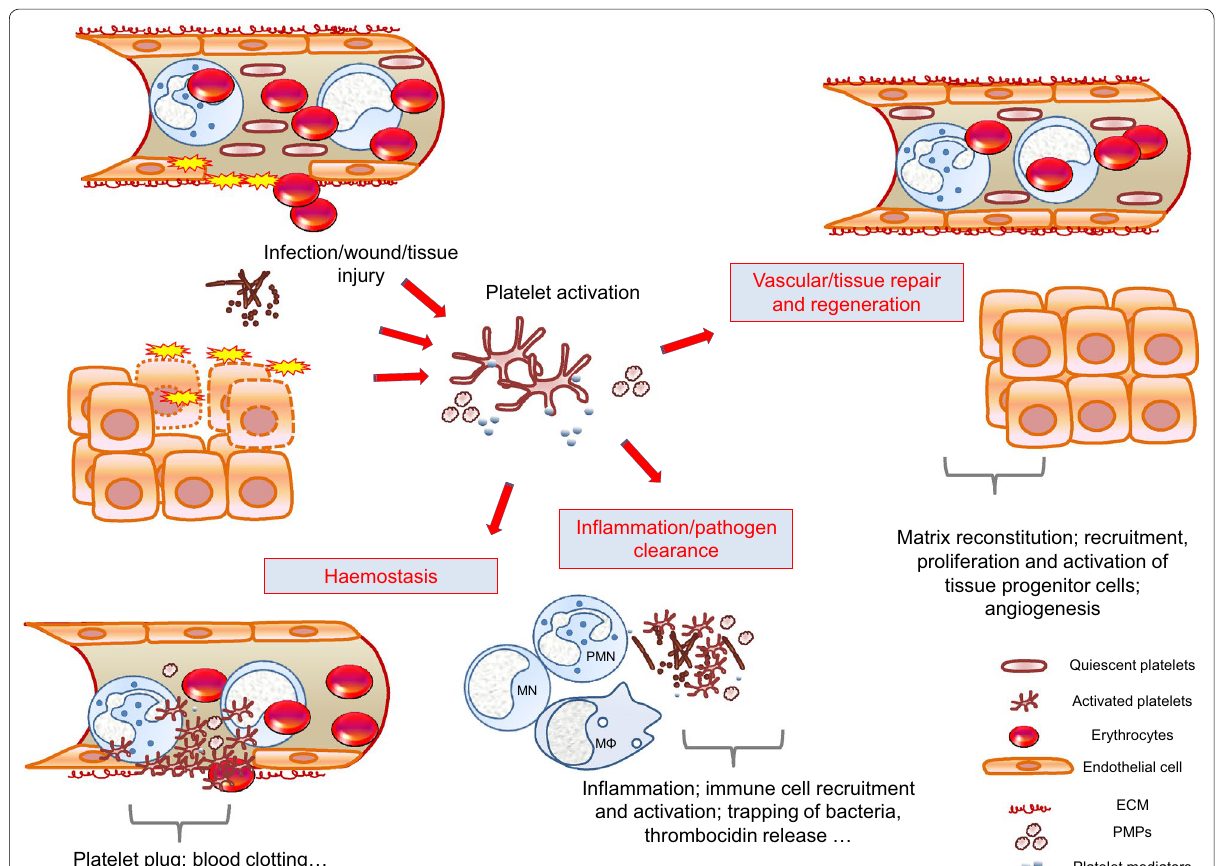
Fig. 1 Platelets are integral players in the immune response, linking haemostasis, thrombosis, inflammation, pathogen clearance and tissue repair: a schematic representation. A growing body of evidence highlights a role for platelets beyond the confines of haemostasis and thrombosis. Some of platelet interfaces in innate immune response are schematized. Platelets are activated at sites of infection/tissue injury. Platelets and platelet- derived mediators contribute to arrest bleeding, to clear pathogens directly or indirectly by acting on various steps of the immune response, and to drive vascular/tissue repair by providing matrix building blocks and a multiplicity of signals that remodel matrix, attracting tissue progenitor cells and reconstructing the vascular frame. In doing so, platelets provide a coherent biological response contributing to cure infection and re-establish tissue architecture and homoeostasis. Scales are arbitrary. Platelet-derived microparticles (PMPs) recapitulate several of activated platelet functions. ECM extracellular matrix, MN monocytes, PMN polymorphonuclear neutrophils, MΦ